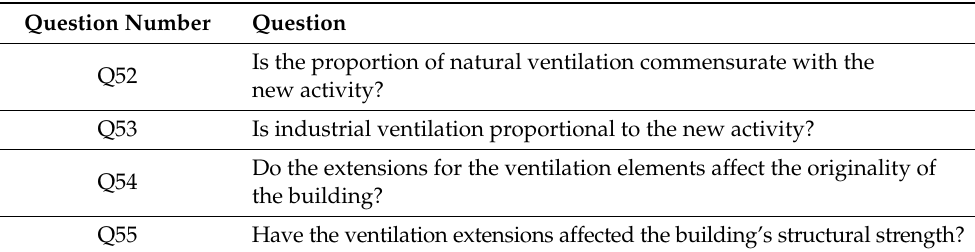
Table 10. Interior design questions (ventilation) .